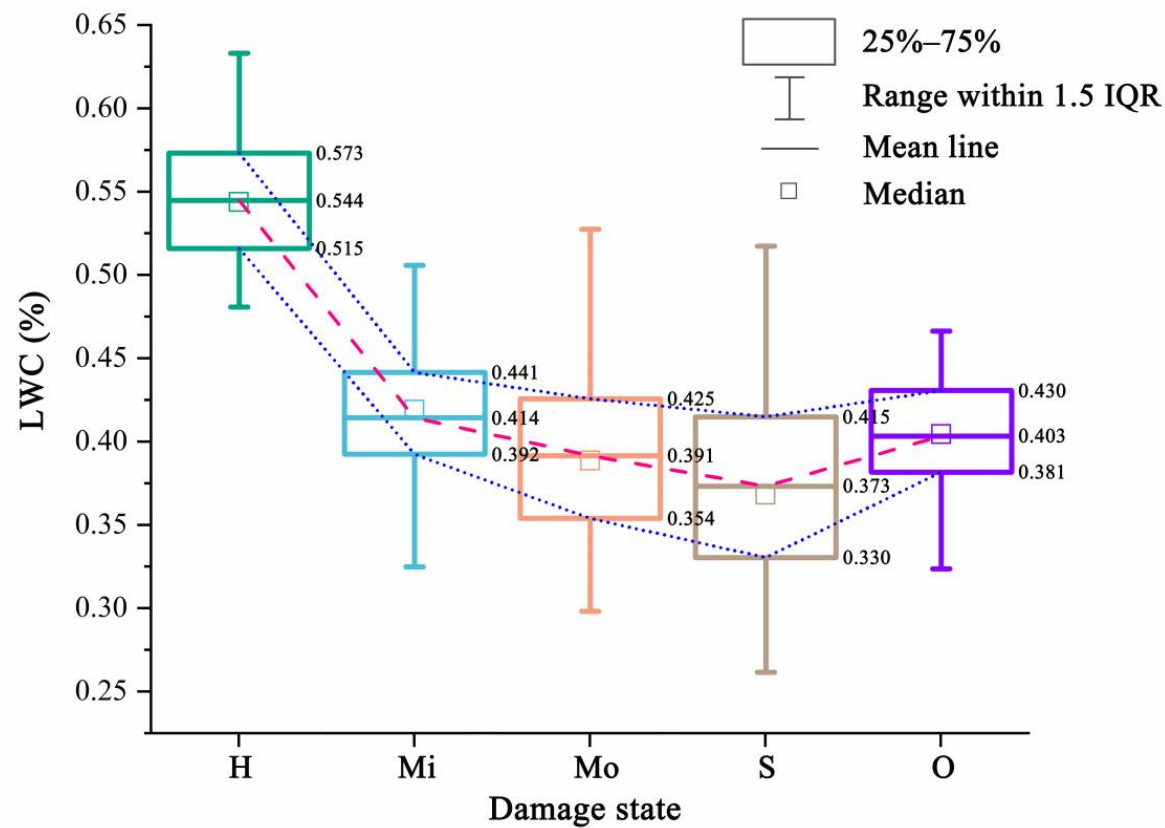
Table 2. ANOVA analysis of LWC of moso bamboo leaves under different damage levels.